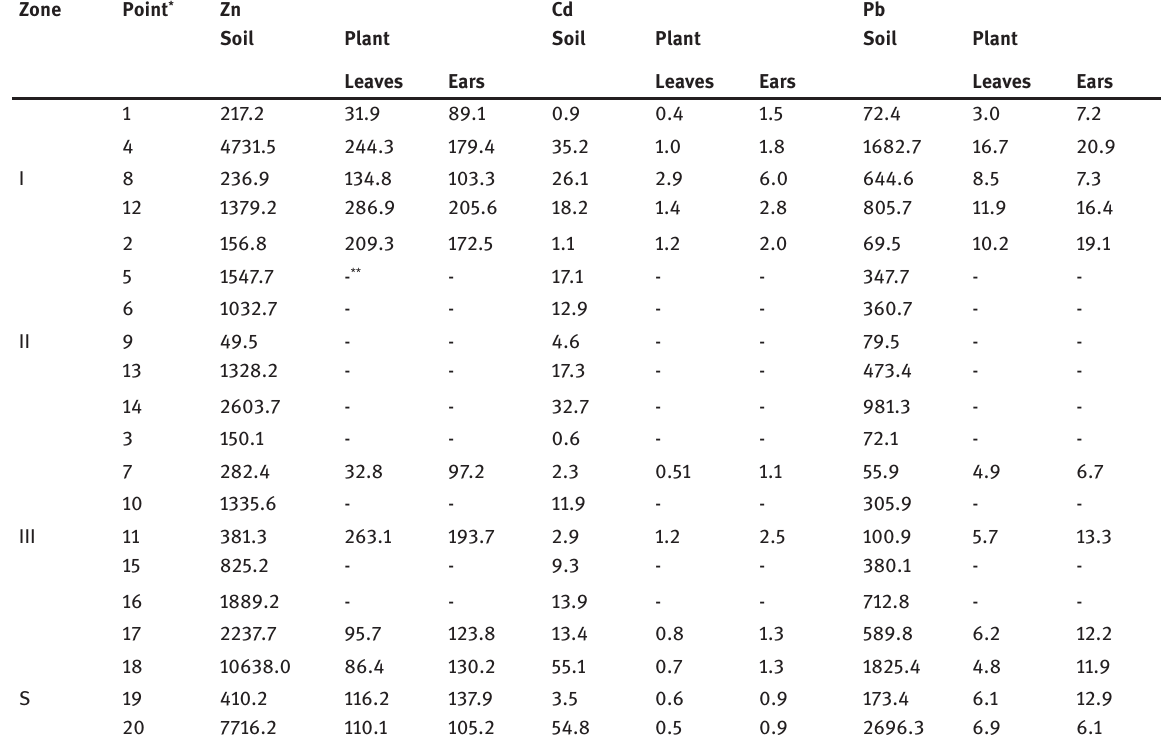
Table 1: Content of heavy metals in the soil and plants around the tailing landfill (mg ∙ kg -1 d.m.) Zone Point